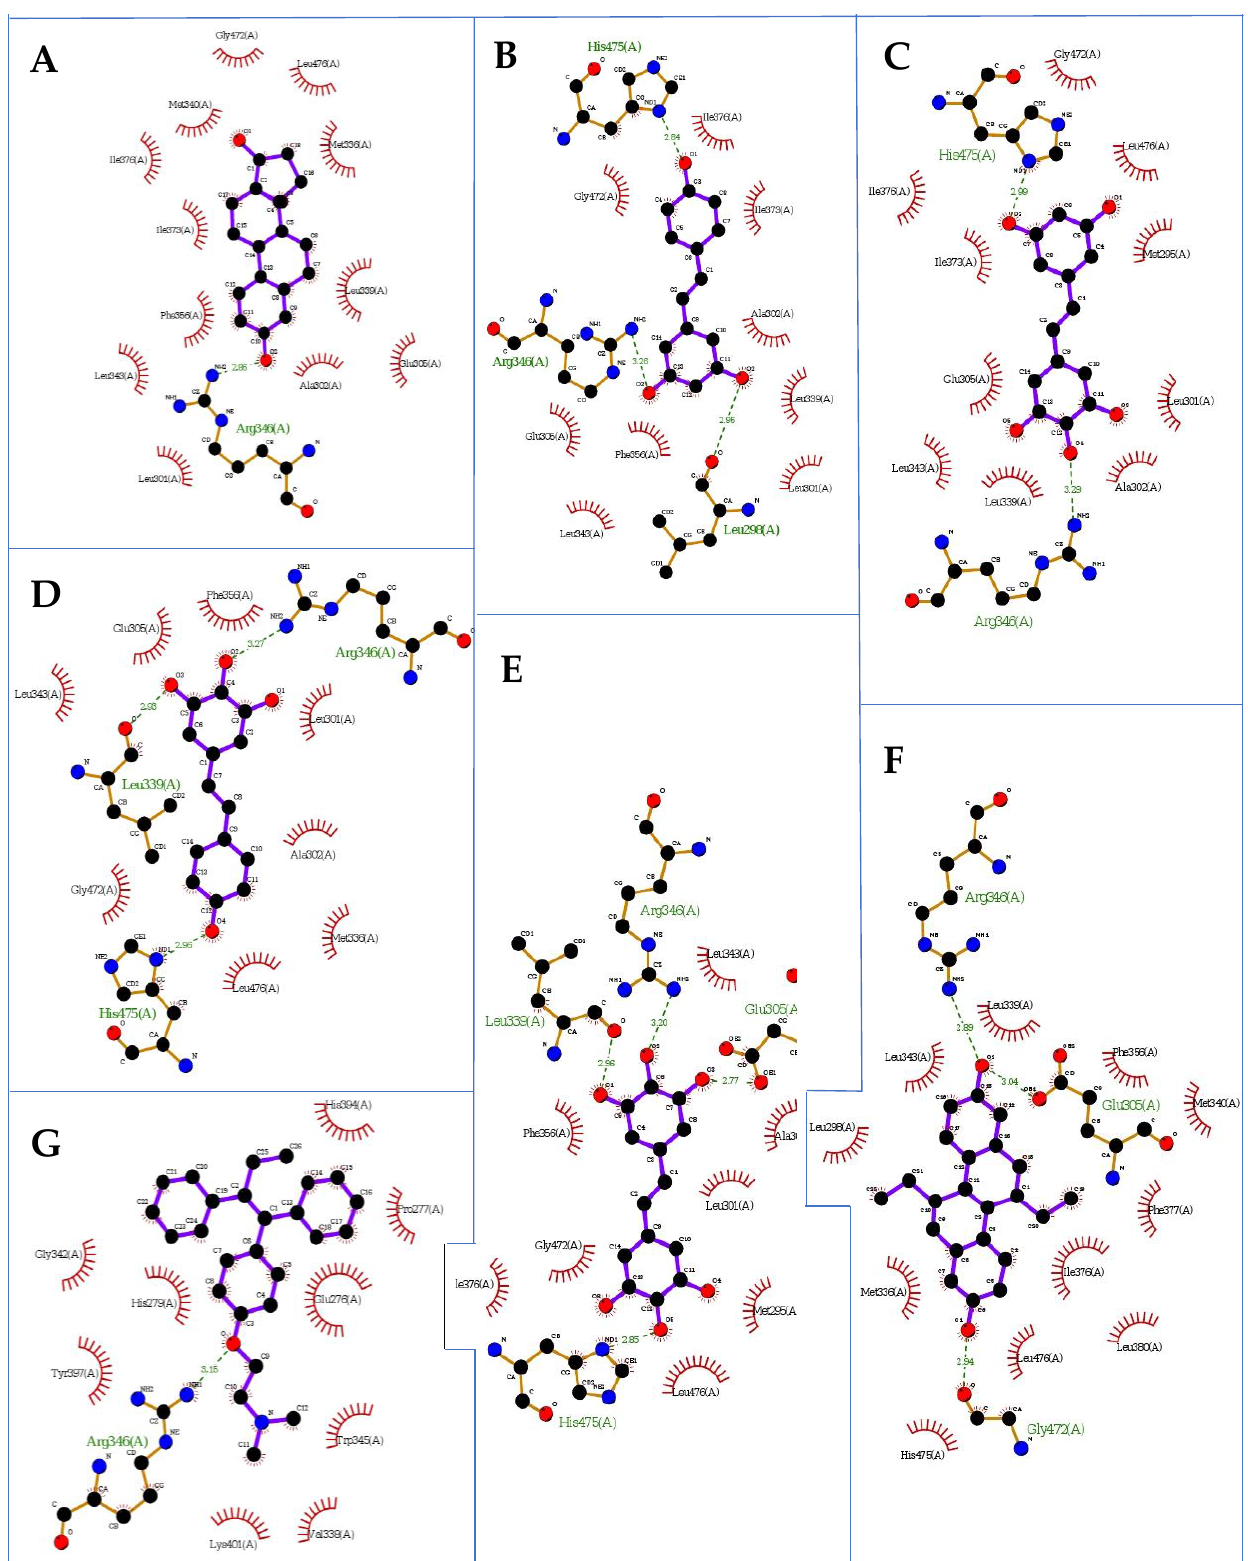
Figure 4. The first poses of the docked ligands to ERβ: ( A ) estradiol, ( B ) resveratrol, ( C ) M11 , ( D ) M8 , ( E ) M12 , ( G ) tamoxifen, and ( F ) GW368; hydrogen atoms are omitted; 3dt3.pdb protein (LigPlot+ v.2.2 software).